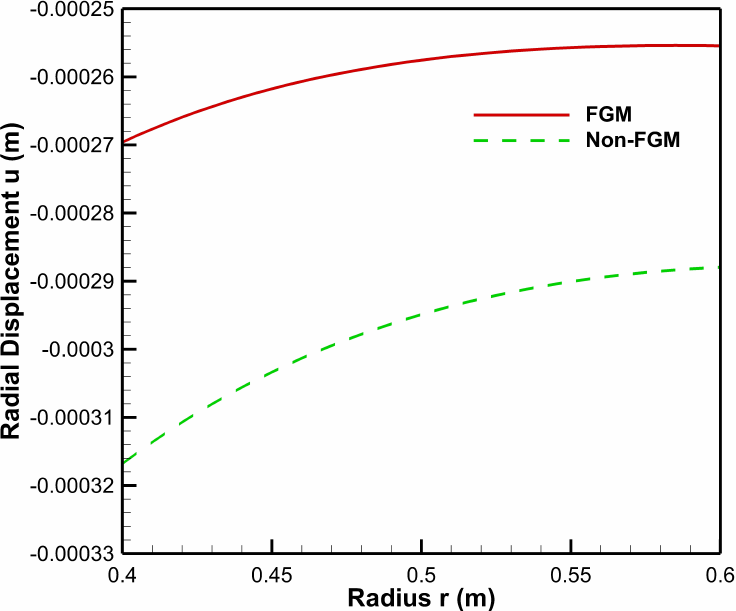
Figure 9. Radial displacement along the radius of the cylinder under external pressure, P b = 50